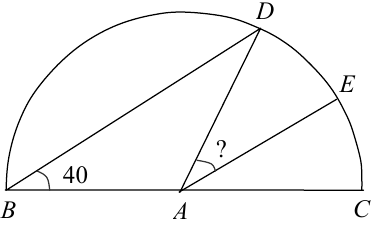
Fig. 4a. A sample